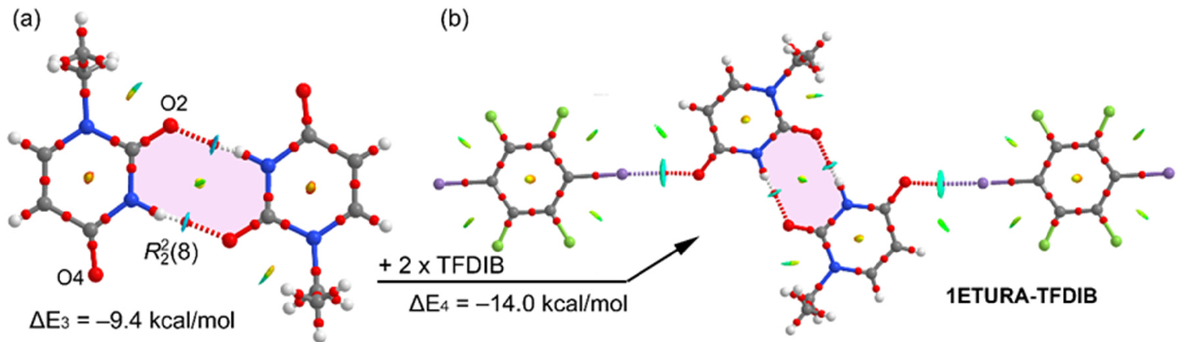
Figure 7. ( a ) QTAIM distribution of bond and ring CPs (red and yellow spheres, respectively) and NCIplot of the R 2 (8) dimer of compound 1ETURA-TFDIB. ( b ) QTAIM distribution of bond and ring CPs (red and yellow spheres, respectively) and NCIplot of the tetramer of compound 1ETURA–TFDIB. The formation energies ( Δ E) computed at the PBE0-D3/def2-TZVP level of theory are also indicated.